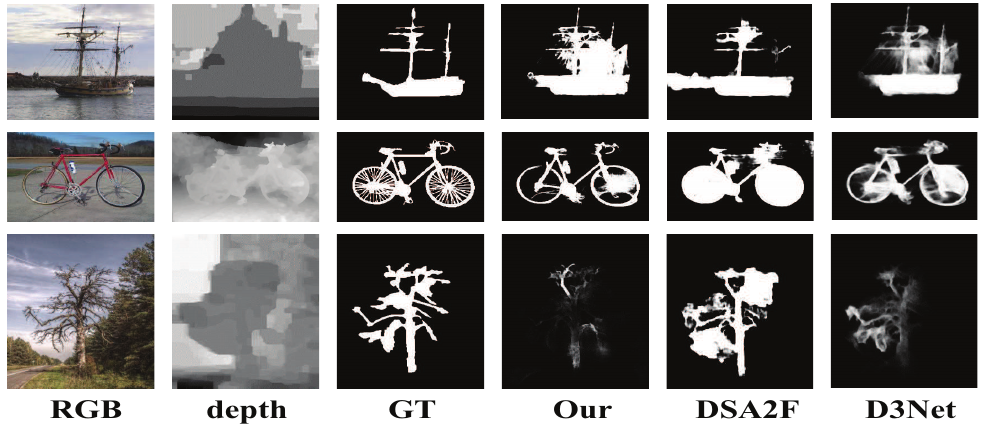
Figure 8. Some failure cases of replacedour model A2TPNet, DSA2F [58], and D3Net [26]. The top two rows show the salient objects with occlusion, and the bottom rows show the salient objects with abundant